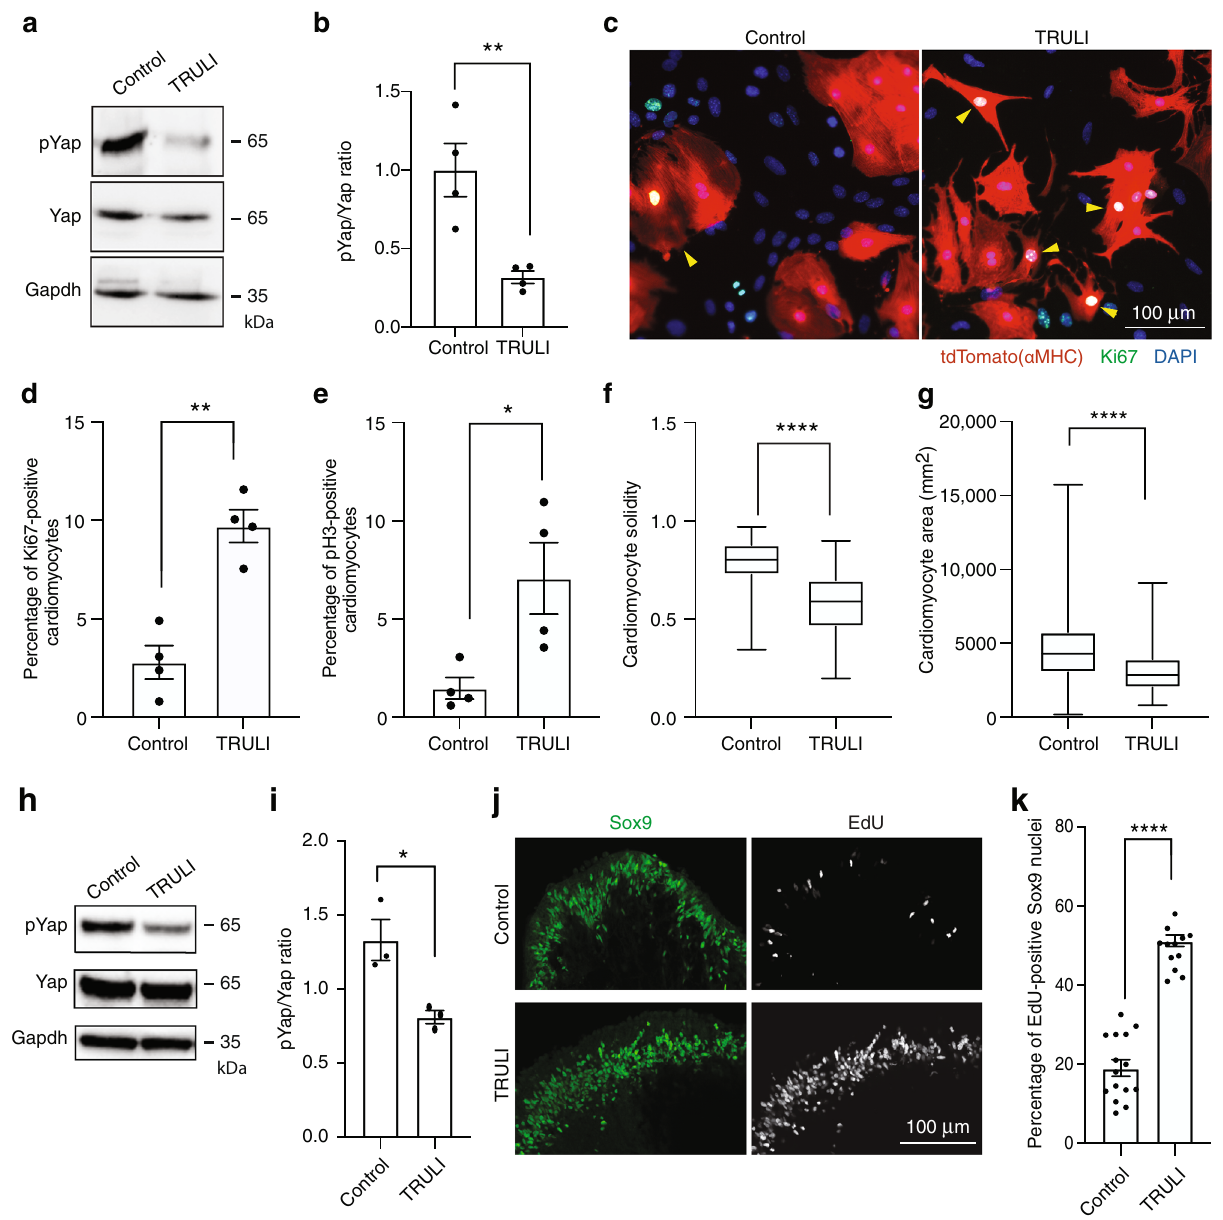
Fig. 6 Proliferation of cardiomyocytes and Müller cells. a A protein immunoblot indicates that TRULI decreases the phosphorylation of Yap in neonatal cardiomyocytes in vitro. b Quanti fi cation of the data in panel a shows the signi fi cance of the effect ( p = 0.008 by an unpaired, two-tailed t -test, n = 4 independent biological samples, mean ± SEM). c Immuno fl uorescent labeling discloses that 3 days of TRULI treatment elevates the cell-cycle marker Ki67 (arrowheads) in cardiomyocytes. Scale bars, 100 μ m. d Quanti fi cation again reveals signi fi cant effects for Ki67 ( p = 0.001 by an unpaired, two-tailed t -test, n